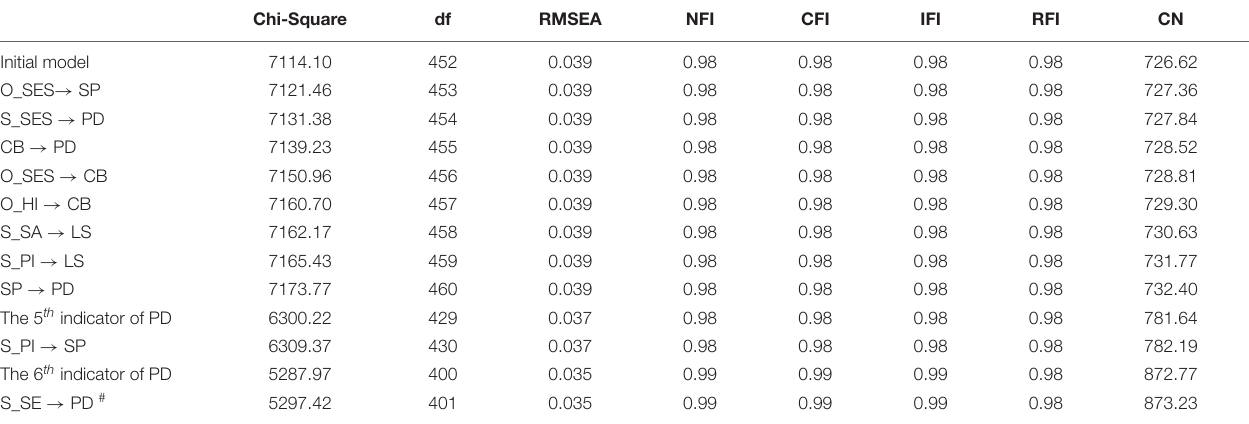
TABLE 3 | Measures of fit for the life satisfaction and psychological distress model of young internal Chinese migrants.